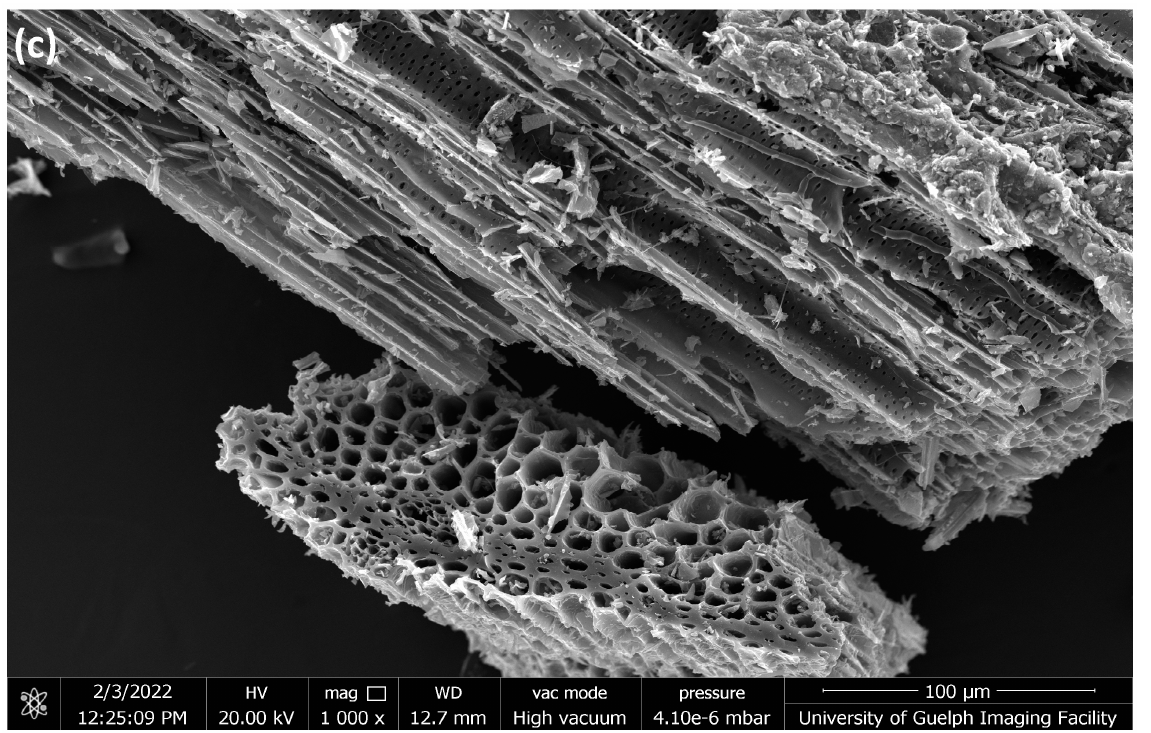
Figure 5. SEM images (200 µm) of switchgrass biocarbon obtained from pyrolysis at ( a ) 450 °C, ( b ) 550 °C, and ( c ) 650 °C, respectively.